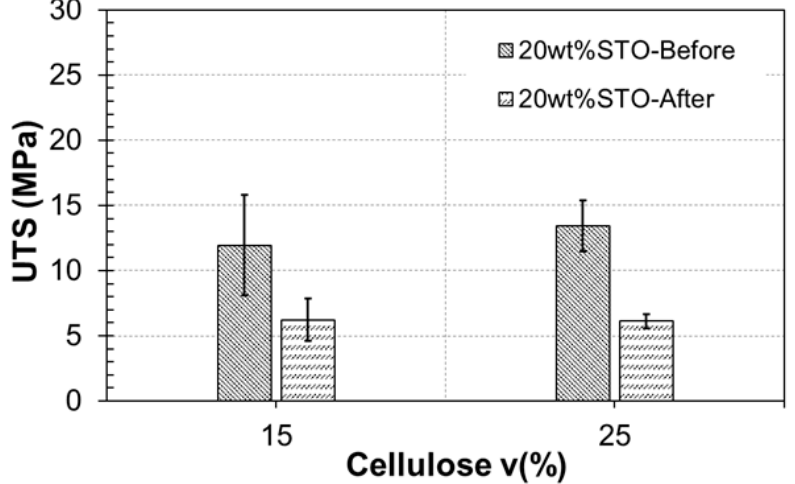
Figure 14. Tensile analysis for degraded bio-composites made of 15 v% and 25 v% of cellulose in hydrochloric acid solution.